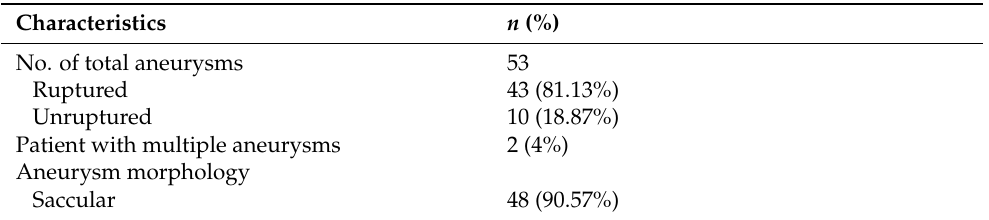
Table 2. Aneurysms